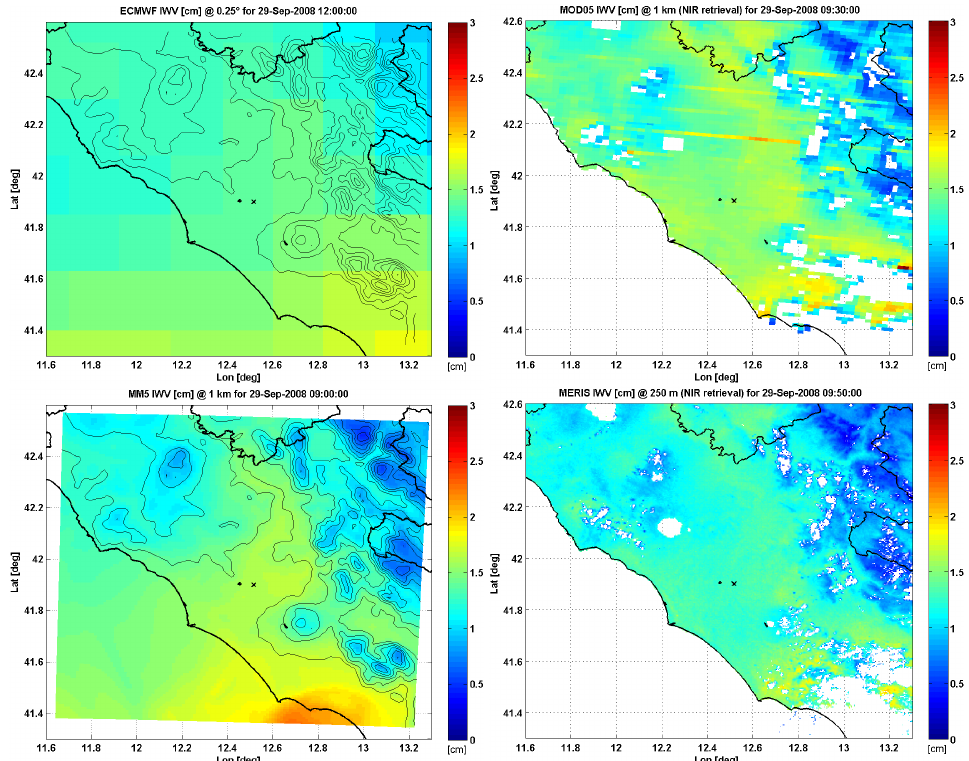
Fig. 5. IWV maps from different estimate sources. Left: ECMWF (top) and MM5 (bottom); black thin lines indicate surface contour at 200m intervals from 100 to 1700m Right: MODIS (top) and MERIS (bottom). Note that NIR-based IWV retrievals (left panels) are not available over ocean. Note also that MODIS and MERIS infrared observations are affected by clouds and thus are screened using the operational cloud mask provided in the original MODIS and MERIS